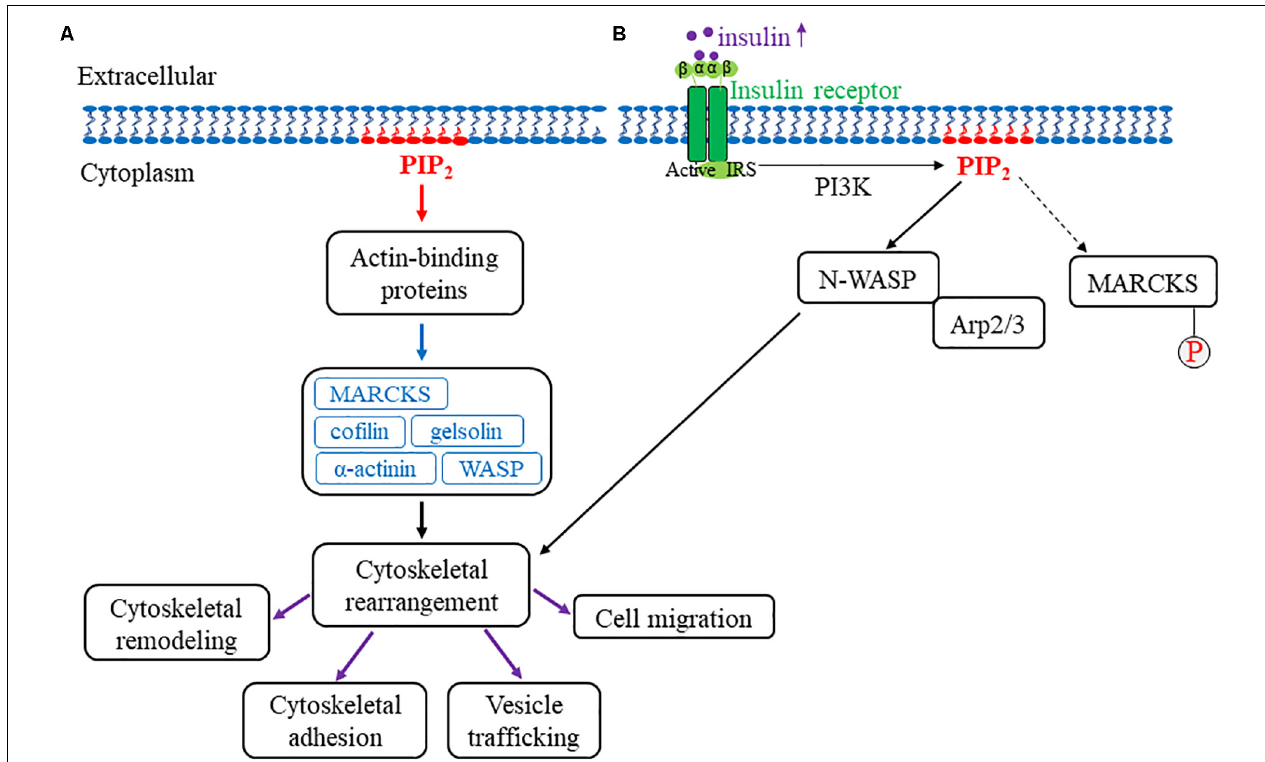
FIGURE 2 | Model for PIP 2 association with the actin cytoskeleton. (A) An overview of PIP 2 ’s role in actin cytoskeletal remodeling. The red arrow represents PIP 2 intracellular association with actin-binding proteins. The blue arrow represents the various PIP 2 -associated actin-binding proteins, including MARCKS, cofilin, WASP, gelsolin, and α -actinin. Upon interaction with PIP 2 , these proteins collectively mediate cellular cytoskeletal rearrangement (indicated by the black arrow). More specifically, actin cytoskeletal remodeling, cytoskeletal adhesion, vesicle trafficking, and cell migration are associated with cytoskeletal rearrangements that are mediated by PIP 2 interaction with actin-binding proteins and are indicated by the purple arrows. (B) This figure depicts how PIP 2 regulates cytoskeletal rearrangement through N-WASP and Arp2/3 with MARCKS phosphorylation. Once the insulin receptor is activated, insulin increases intracellularly and subsequently mediates the dissociation of MARCKS from PIP 2 (as indicated by the dotted arrow) in which MARCKS is subsequently phosphorylated and activated. In addition, PIP 2 separately binds to and activates both N-WASP and Arp2/3, which drives actin cytoskeletal rearrangement. Together, these findings highlight the role of PIP 2 in mechanosensitive actin cytoskeletal rearrangement and